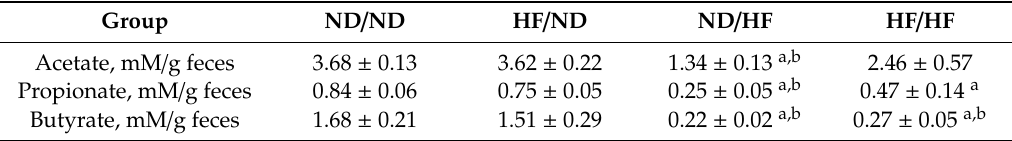
Table 2. Fecal levels of acetate, propionate, and butyrate in in male o ff spring exposed to high-fat diet (HF) at 16 weeks of age.